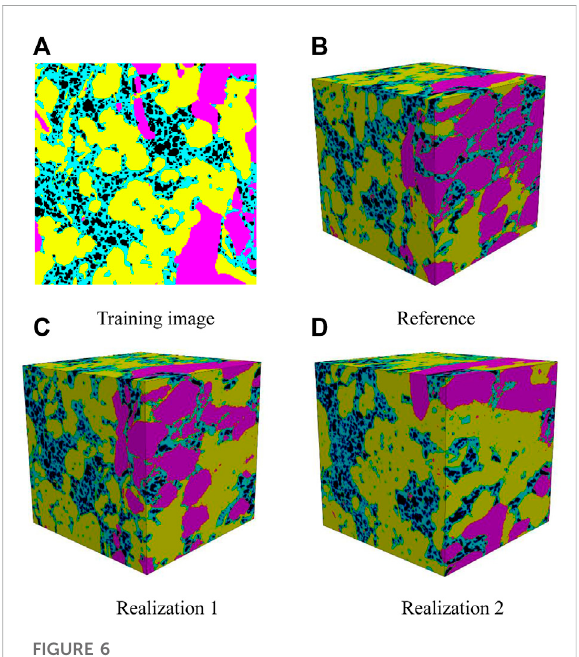
FIGURE 6 Comparison of (A) the 2D training image (B) 3D reference image and (C) and (D) realizations one and two which are reconstructed from the training image using the proposed approach. Black indicates the organic pores, light blue indicates the organic matter, yellow indicates the matrix, and pink represents the